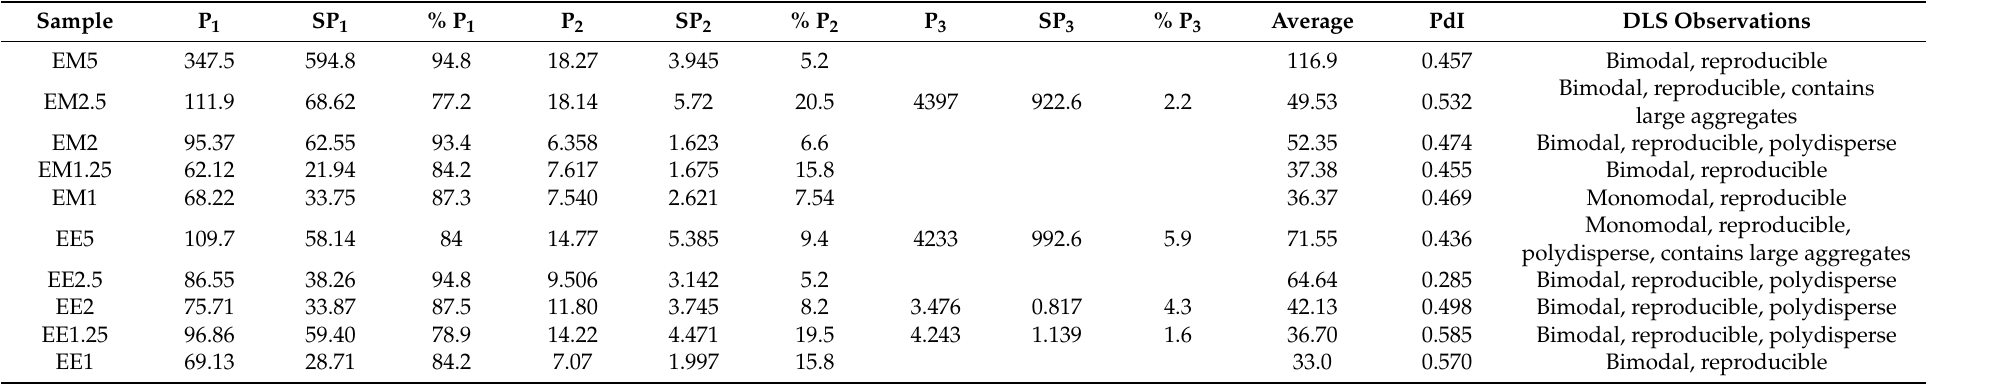
Table 4. Results obtained for the measurement of the particle size via the DLS method. In the table: Px—maximum (peak) X, SPx—standard deviation